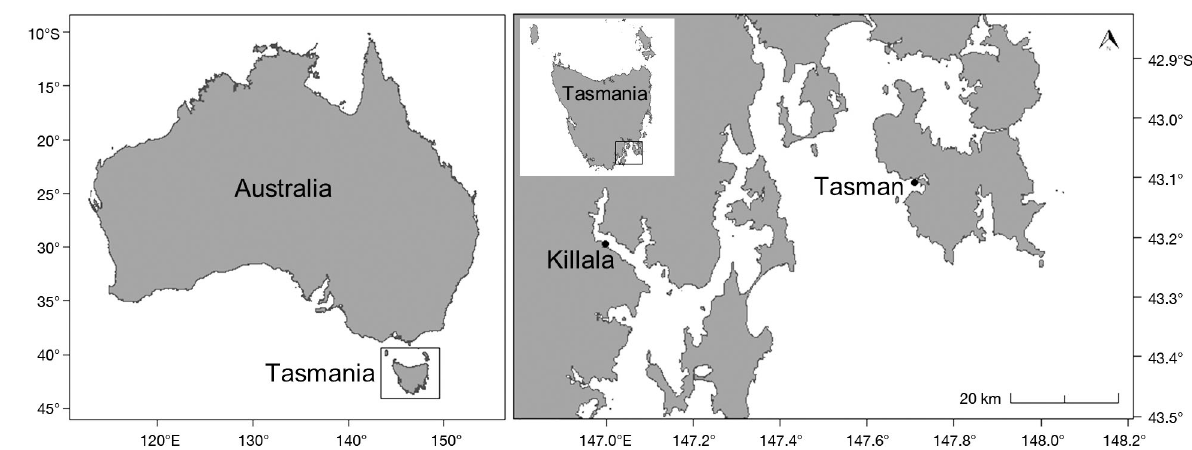
Fig. 1. Atlantic salmon sea pen sites, Killala and Tasman, sampled during the